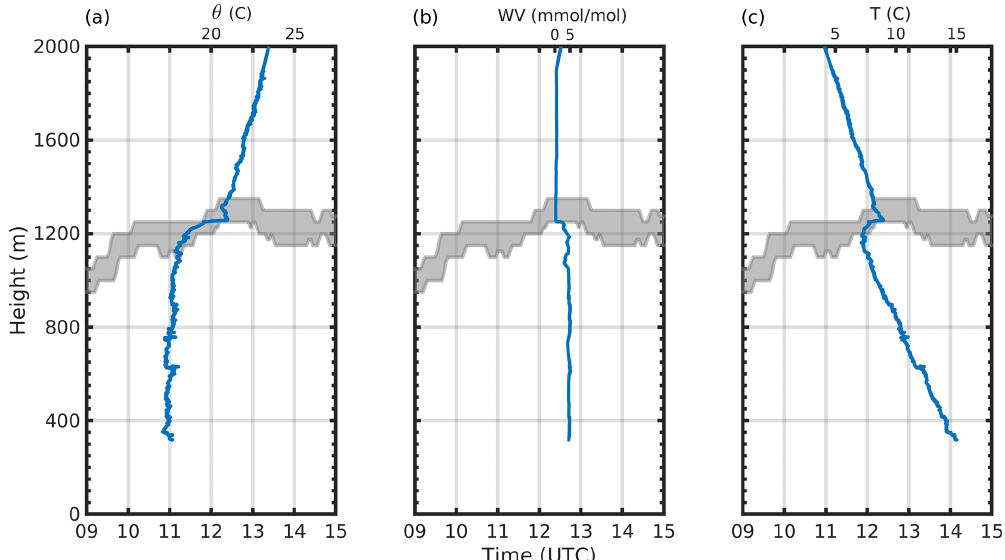
Figure 7. Profiles of the (a) potential temperature, (b) water vapour concentration and (c) temperature during a Cessna flight superimposed on the Bragg scatter area, derived from the C-band radar, on 9 May 2018. The overpass time for Cessna at 1250m is 12:15UTC. Note that the x scales for the flight variables are on top of the graphs.